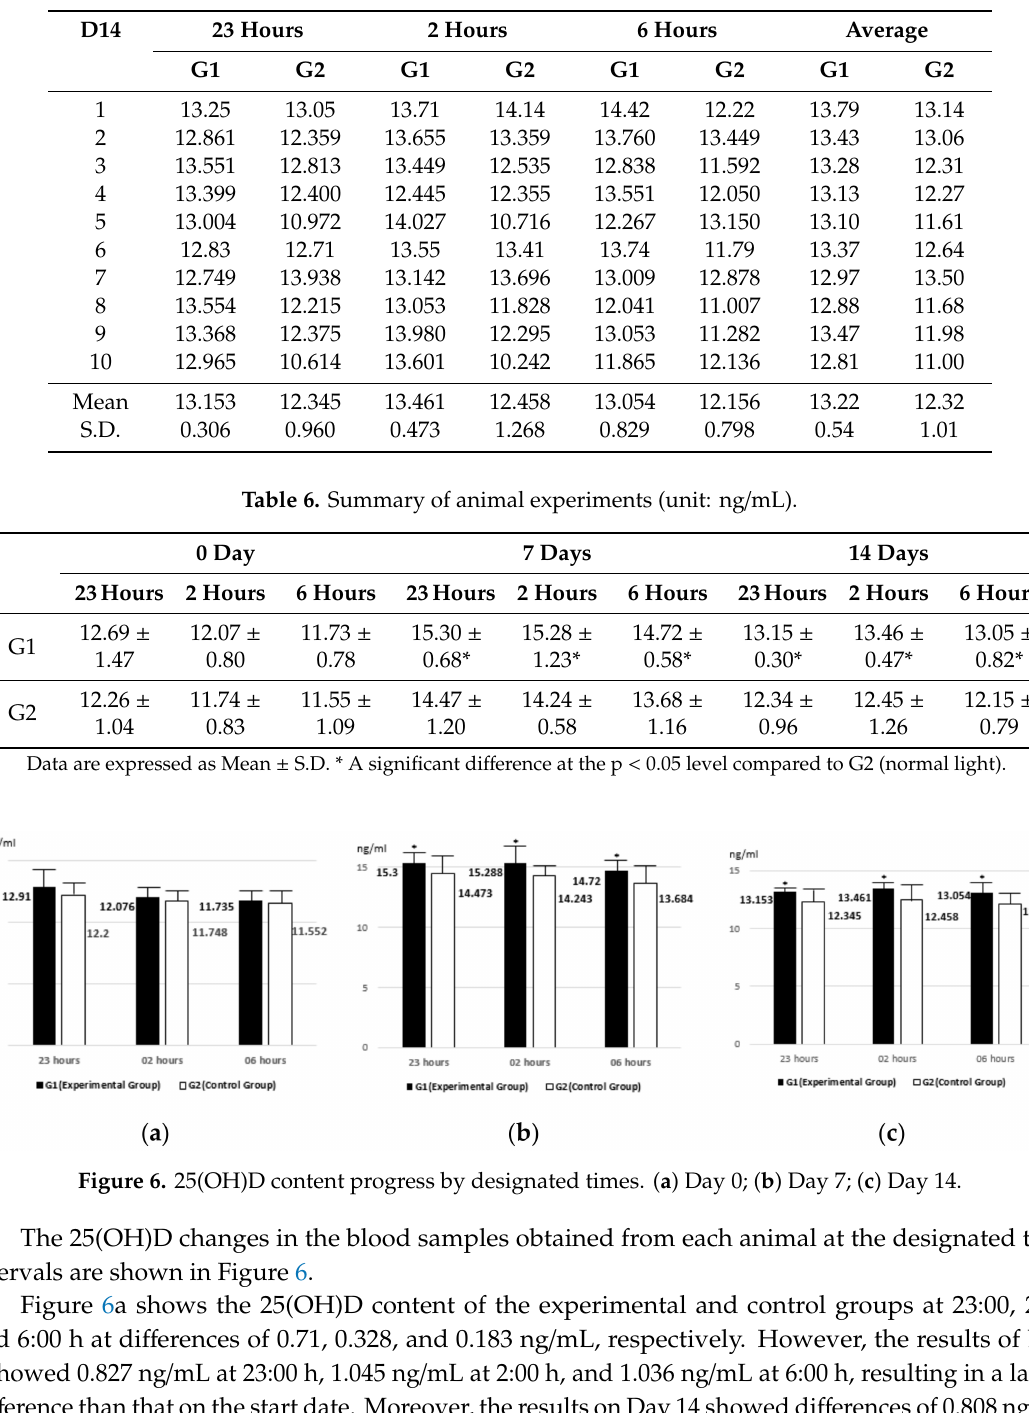
Table 5. Test animal serum 25(OH)D analysis results (D14, unit: ng / mL).